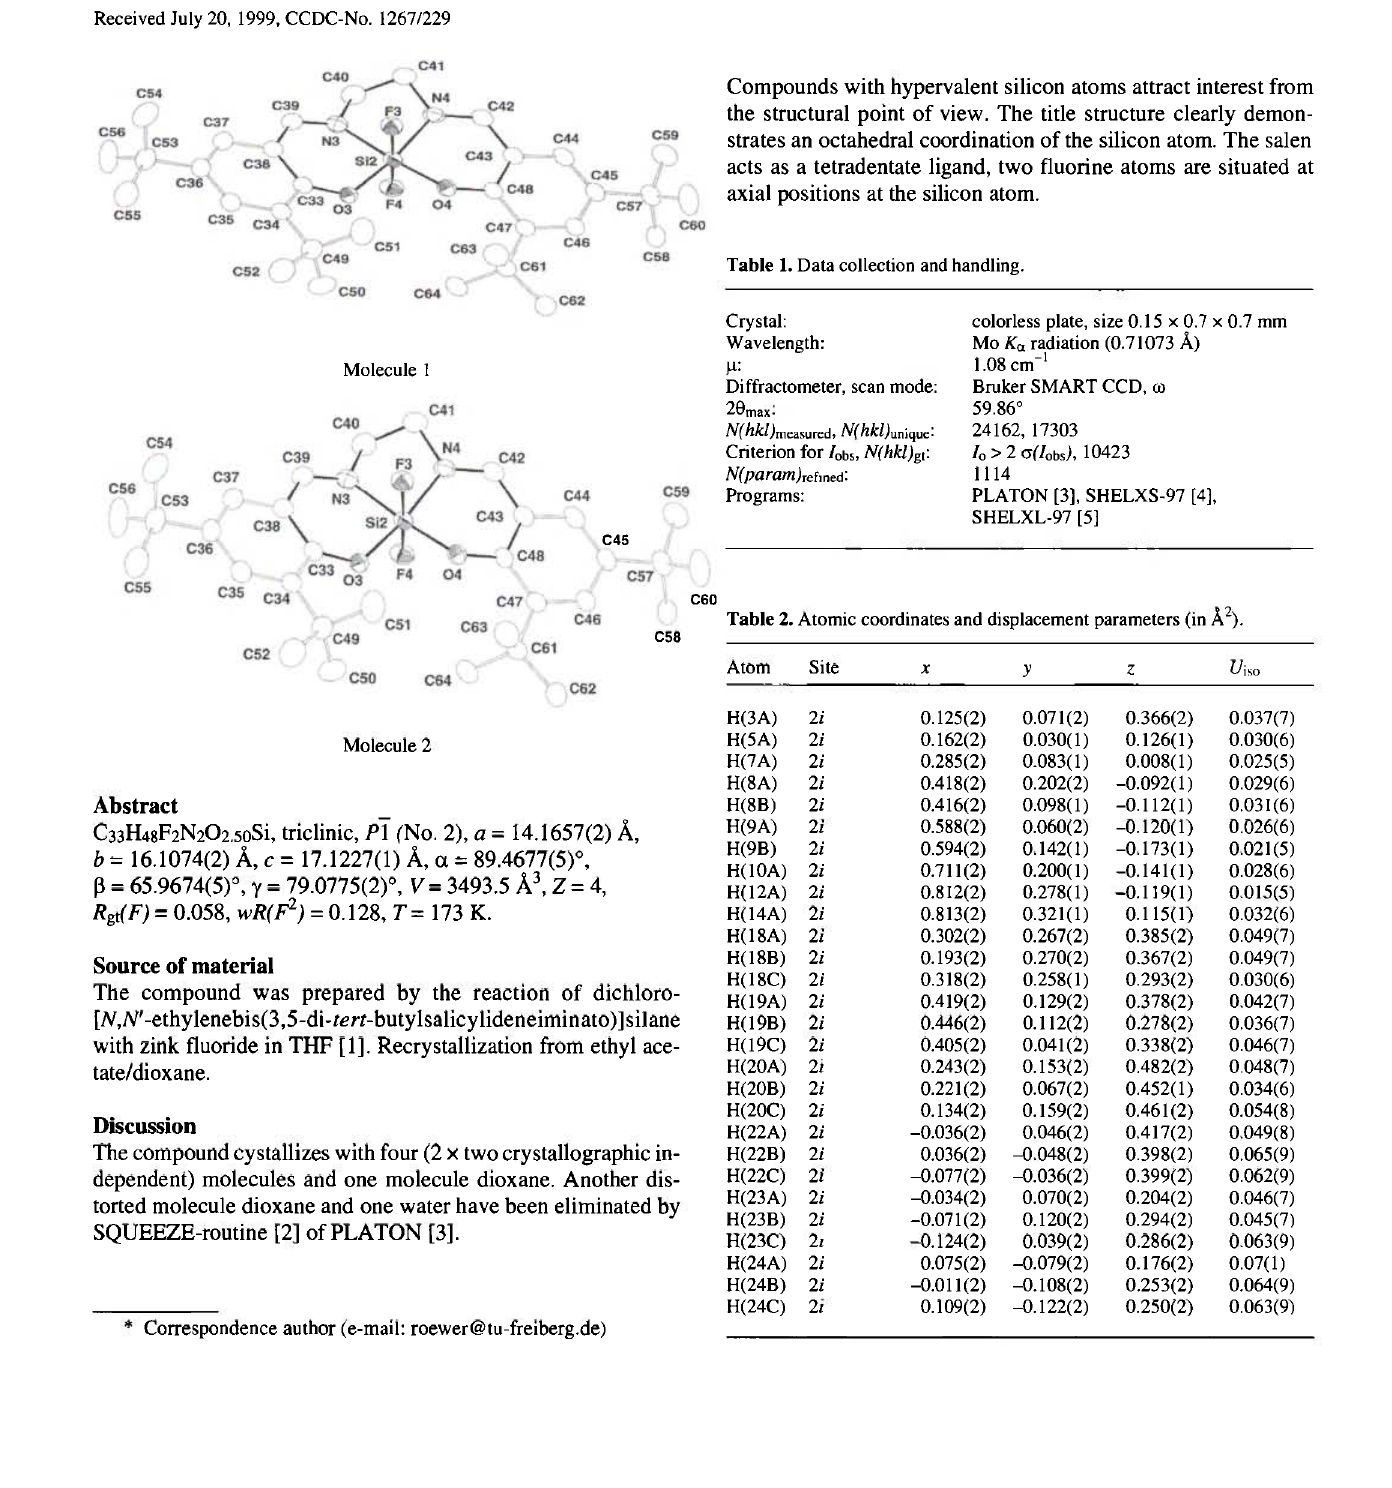
Table 1. Data collection and handling.